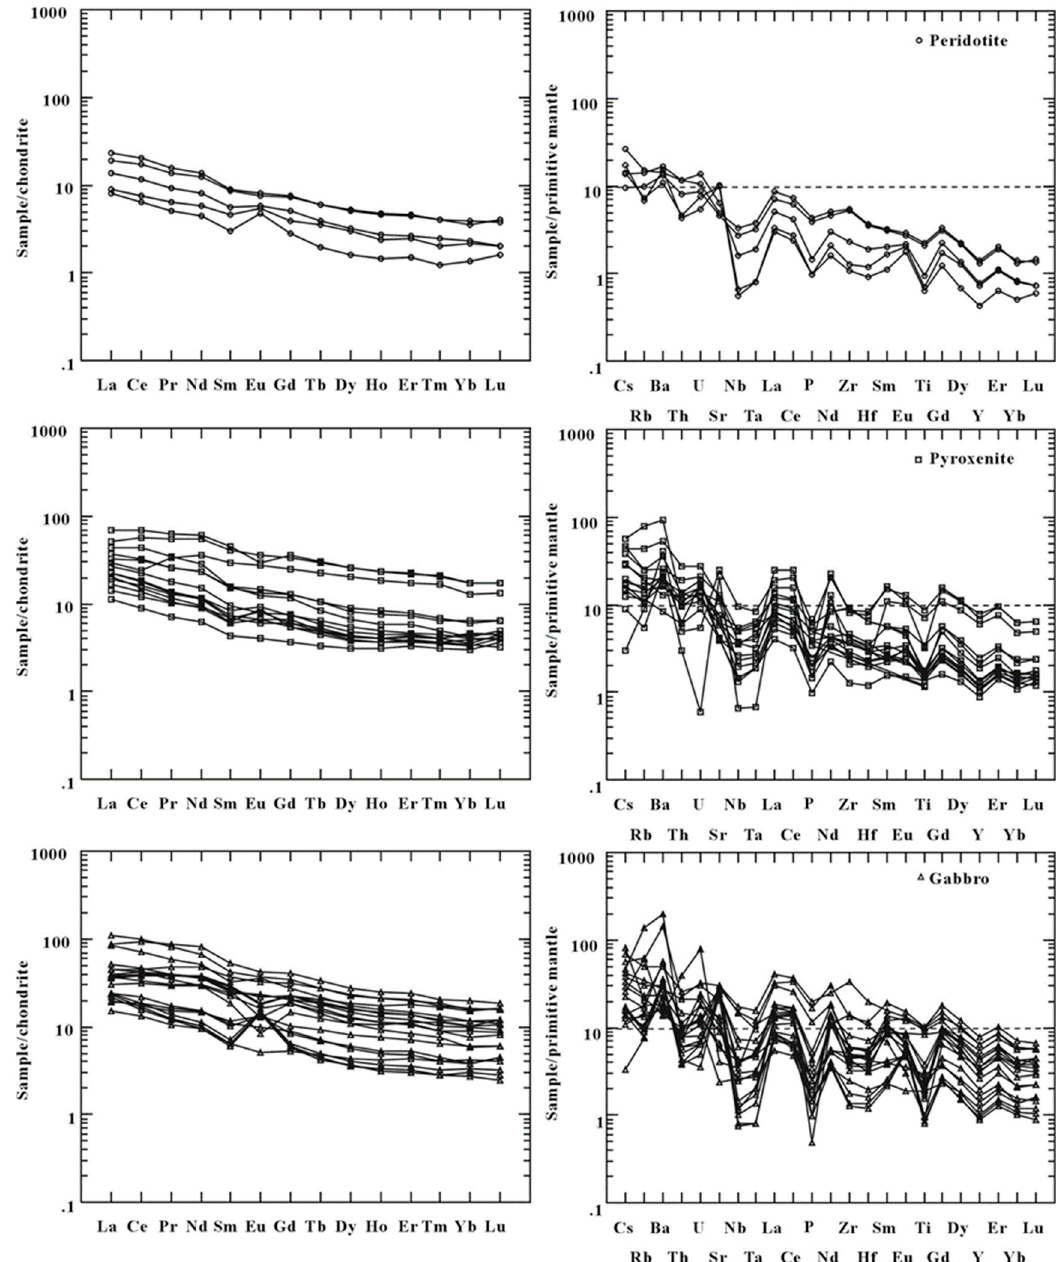
Figure 6. Chondrite-normalized rare earth element (REE) and primitive mantle-normalized trace element patterns for the Xingdi No.2 intrusive rocks. The normalizing values are from [41].